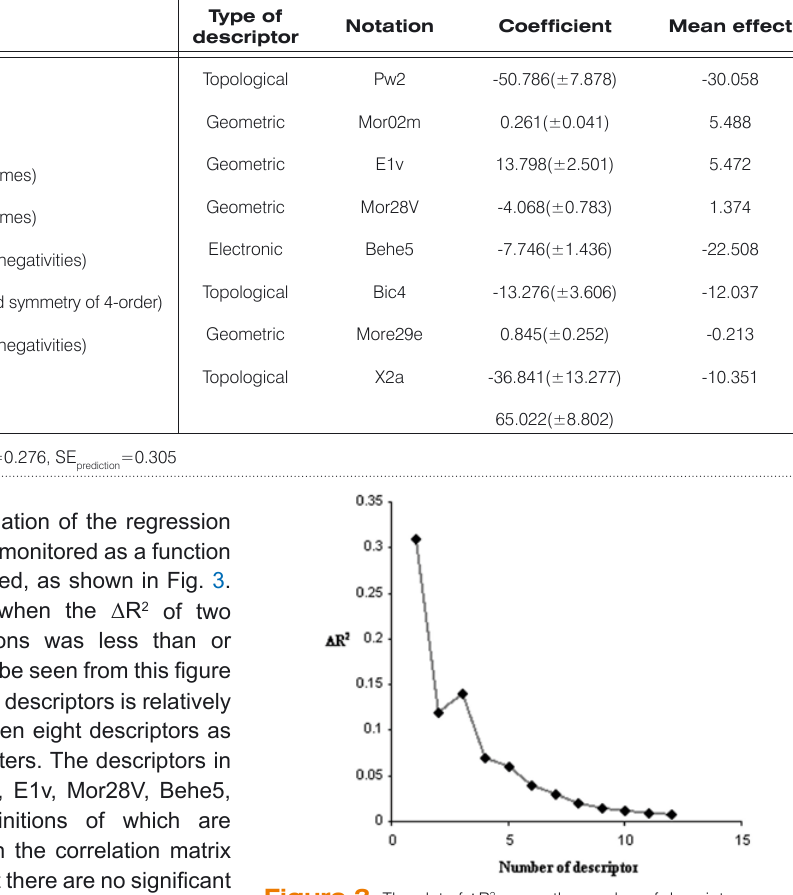
Table 2. Selected descriptors of multiple linear